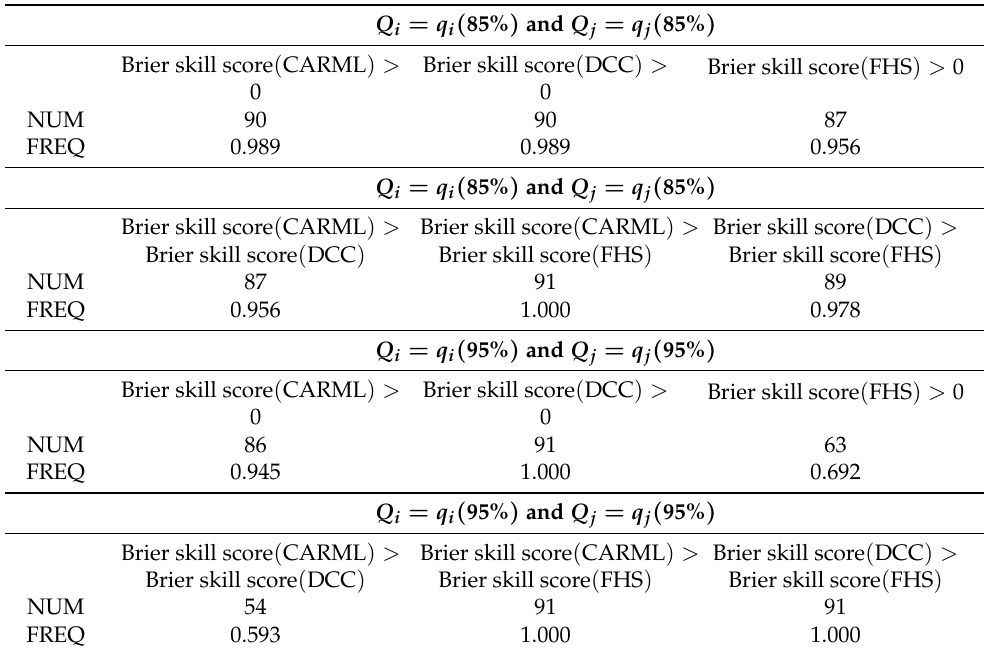
Table 6. Brier skill scores for all pairs of